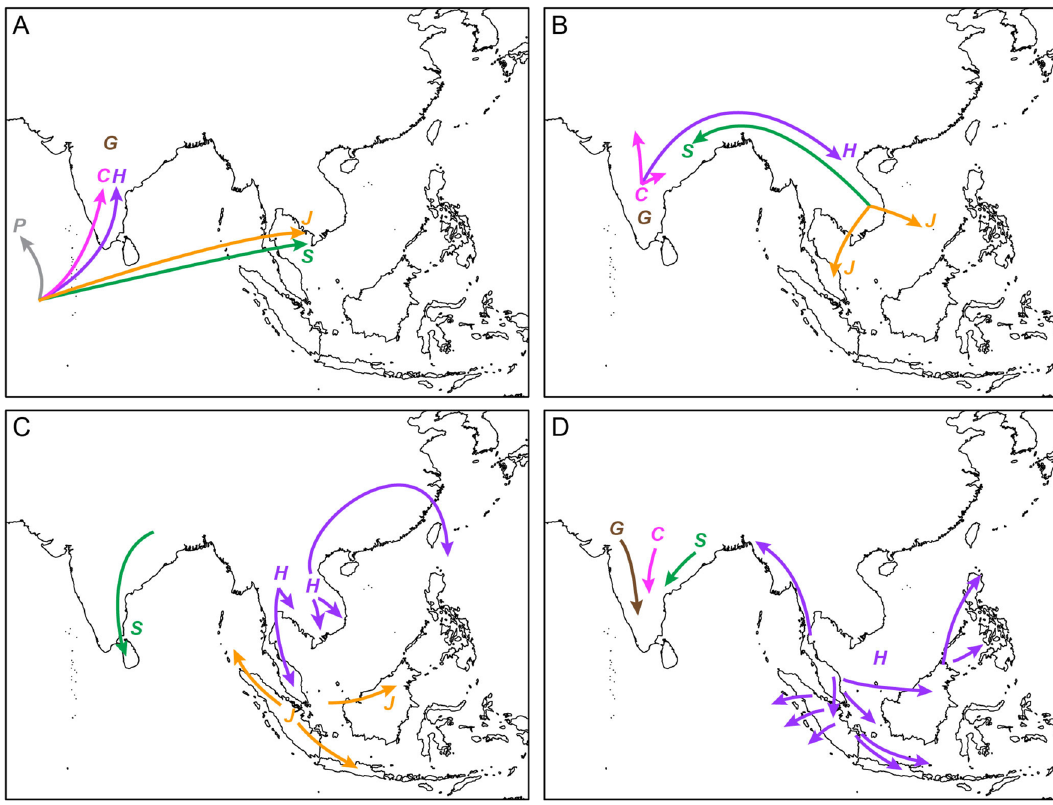
Figure 2. Couzijn’s 23 hypothesis for the evolution and diversification of the Asian forest scorpions (Scorpionidae: Heterometrinae). ( A ) Gondwana origins and divergence: Heterometrinae diverge from Pandinus (Pandininae) ( P ) on Gondwana; the Indian subcontinent rifts from Gondwana, carrying Gigantometrus ( G ) and the ancestor of ( Chersonesometrus + Heterometrus ); the Indochinese landblock rifts from Gondwana, carrying the ancestor of ( Javanimetrus + Srilankametrus ) . ( B ) Dispersal across the Assam gateway: Heterometrus ( H ) disperses east to Southeast Asia; Srilankametrus ( S ) disperses west to India; Javanimetrus ( J ) disperses south and southeast to Borneo, the Philippines and the Malay Peninsula; Chersonesometrus ( C ) disperses north across the Indian subcontinent. ( C ) Tertiary dispersal: Srilankametrus disperses south to Sri Lanka; Javanimetrus disperses northwest to Sumatra and the Nicobar Islands, and east to Java and Borneo; Heterometrus disperses south to Indochina and the Malay Peninsula, and north to the Philippines. ( D ) Pleistocene dispersal: Heterometrus disperses more widely across its range; the Indian taxa disperse south due to glaciation in the